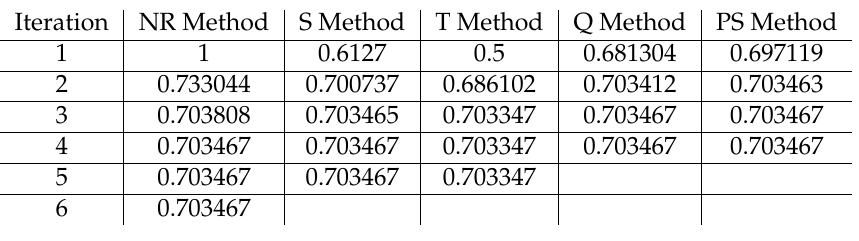
Table 5. Numerical results for the Equation (20)